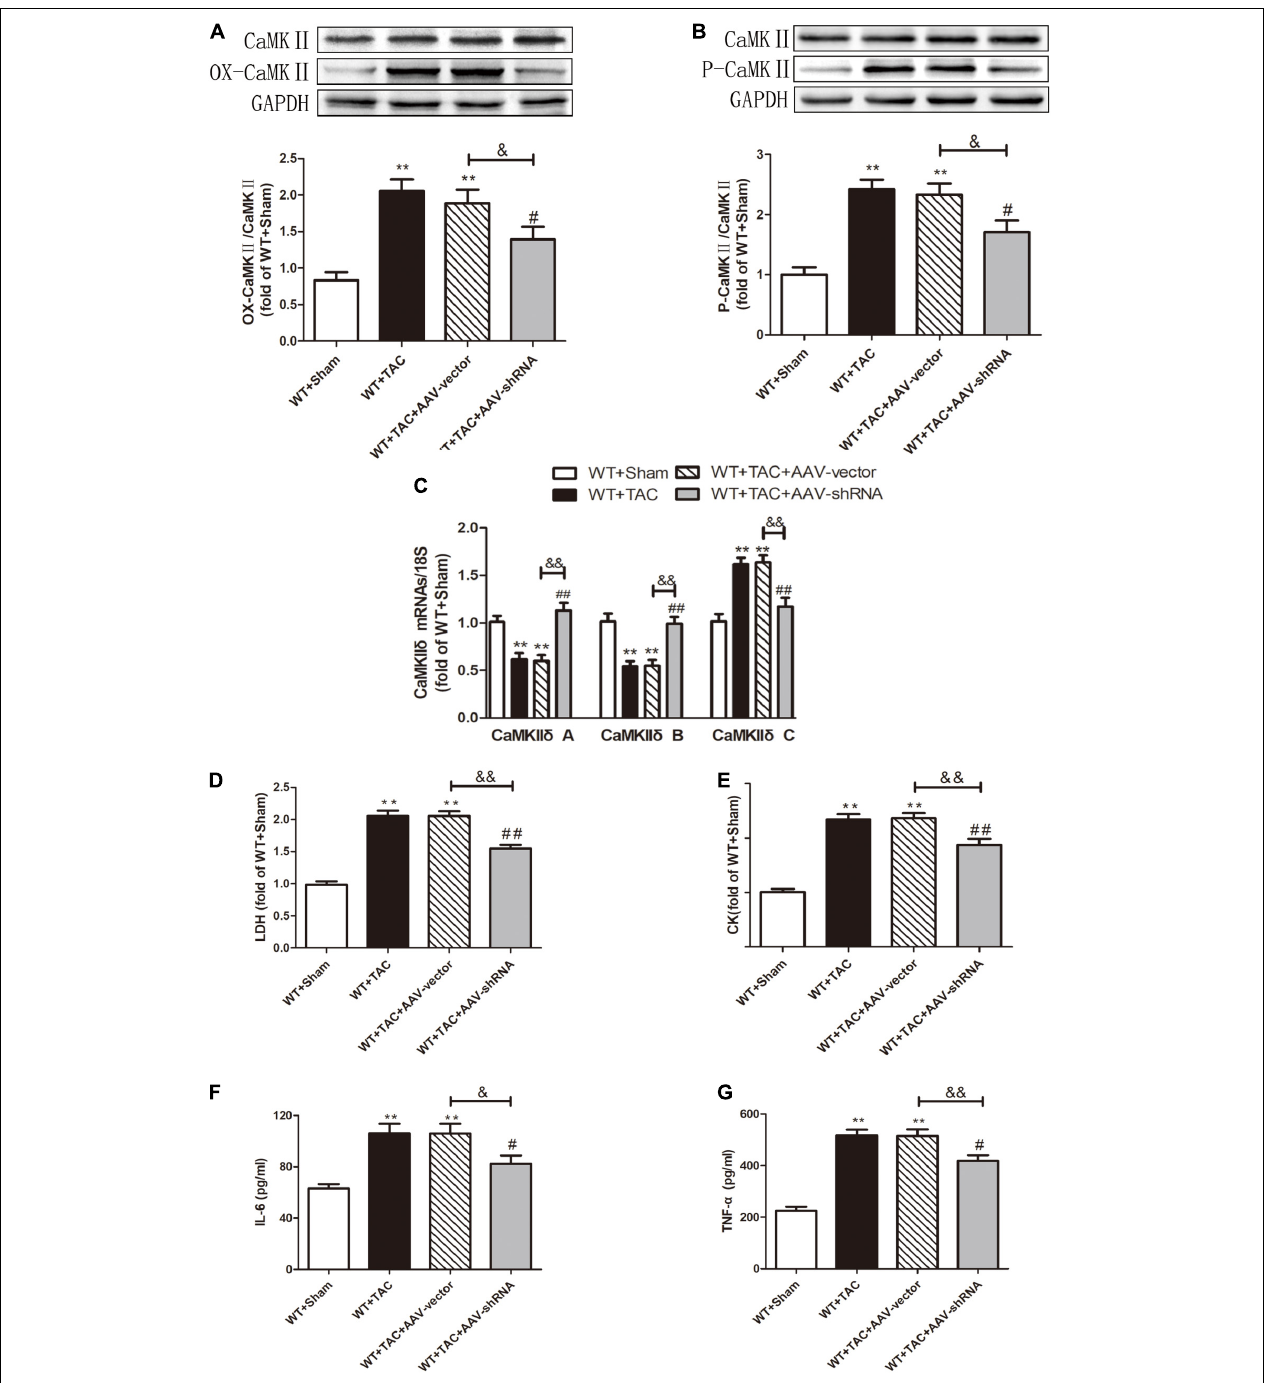
FIGURE 12 | Interference with RIPK3 can alleviate the elevated levels of CaMKII oxidation and phosphorylation, improve CaMKII δ alternative splicing disorder, the degree of myocardial injury, and inflammatory response in HF mice. Male 8-week-old WT mice were pretreated with AAV-vector and AAV-shRNA through the tail vein, and TAC was performed using a 28-g needle. The control group received sham surgery. All groups of mice were given continuous feeding for 6 weeks. Hearts were then obtained for correlative testing. (A) The expression of OX-CaMKII at the protein level in myocardial tissue was detected by Western blotting analysis, and GAPDH was used as a loading control. (B) The expression of P-CaMKII at the protein level in myocardial tissue was detected by Western blotting analysis, and GAPDH was used as a loading control. (C) Detection of myocardial CaMKII δ A, CaMKII δ B, and CaMKII δ C at the mRNA level by qRT-PCR, and 18S was used as the housekeeping gene. (D) The levels of serum LDH, (E) CK, (F) IL-6, and (G) TNF- α . Compared with WT + sham group, ** P < 0.01; compared with WT + TAC group, ## P < 0.01 and # P < 0.05; compared with WT + AAV-vector group, && P < 0.01 and & P < 0.05. n = 6.